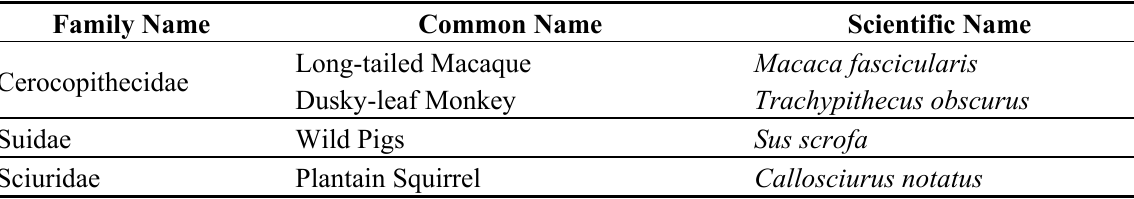
Table 5. List of mammal species detected at Marudu Bay mangrove river